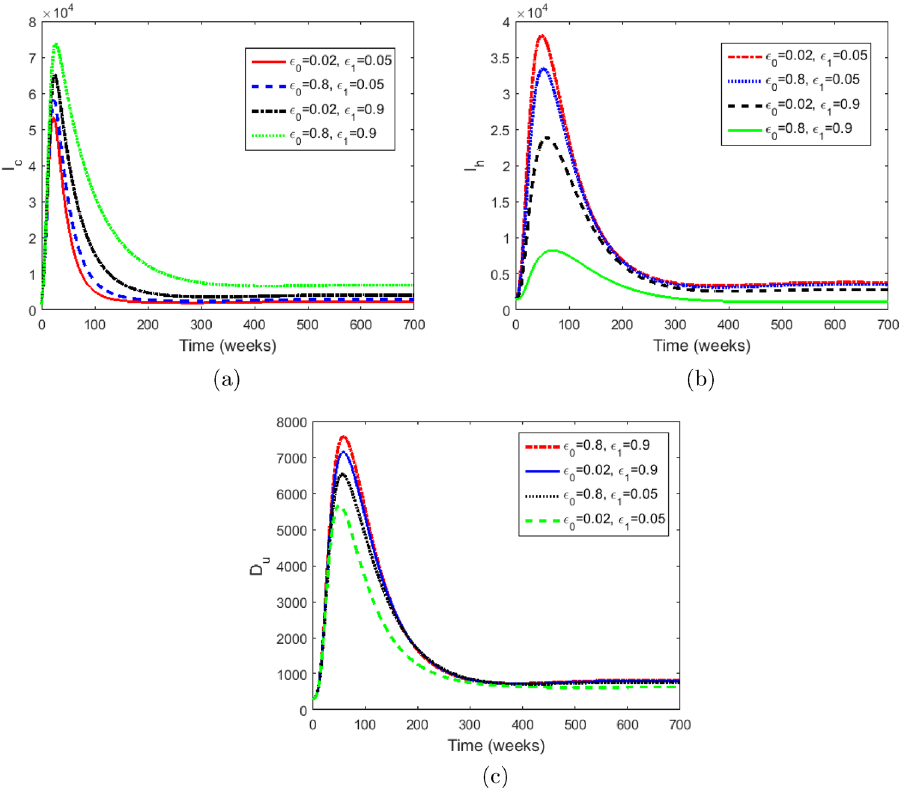
Figure 7. Simulations of the model (2)–(10) with different values of ǫ 0 and ǫ 1 . each graph represents either the case where both epsilons are high, or both low, or one is high, and the other is low. ( a ) The number of infected stigmatised individuals, ( b ) the number of infected unstigmatised individuals, and ( c ) the number of dead bodies that are unsafely buried.